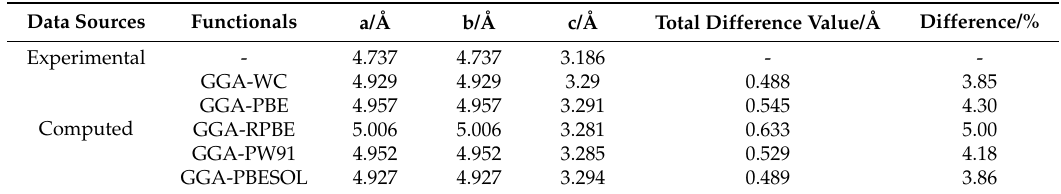
Table 2. Computed cassiterite bulk cell parameters from different GGA functionals compared with experimental values